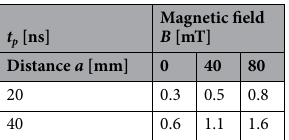
Table 1. Electron beam propagation time t p [ns] in point-plane setup in E × B.